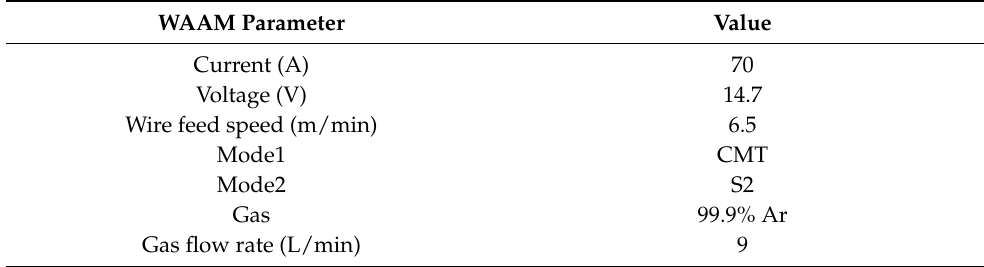
Table 3. Fixed WAAM